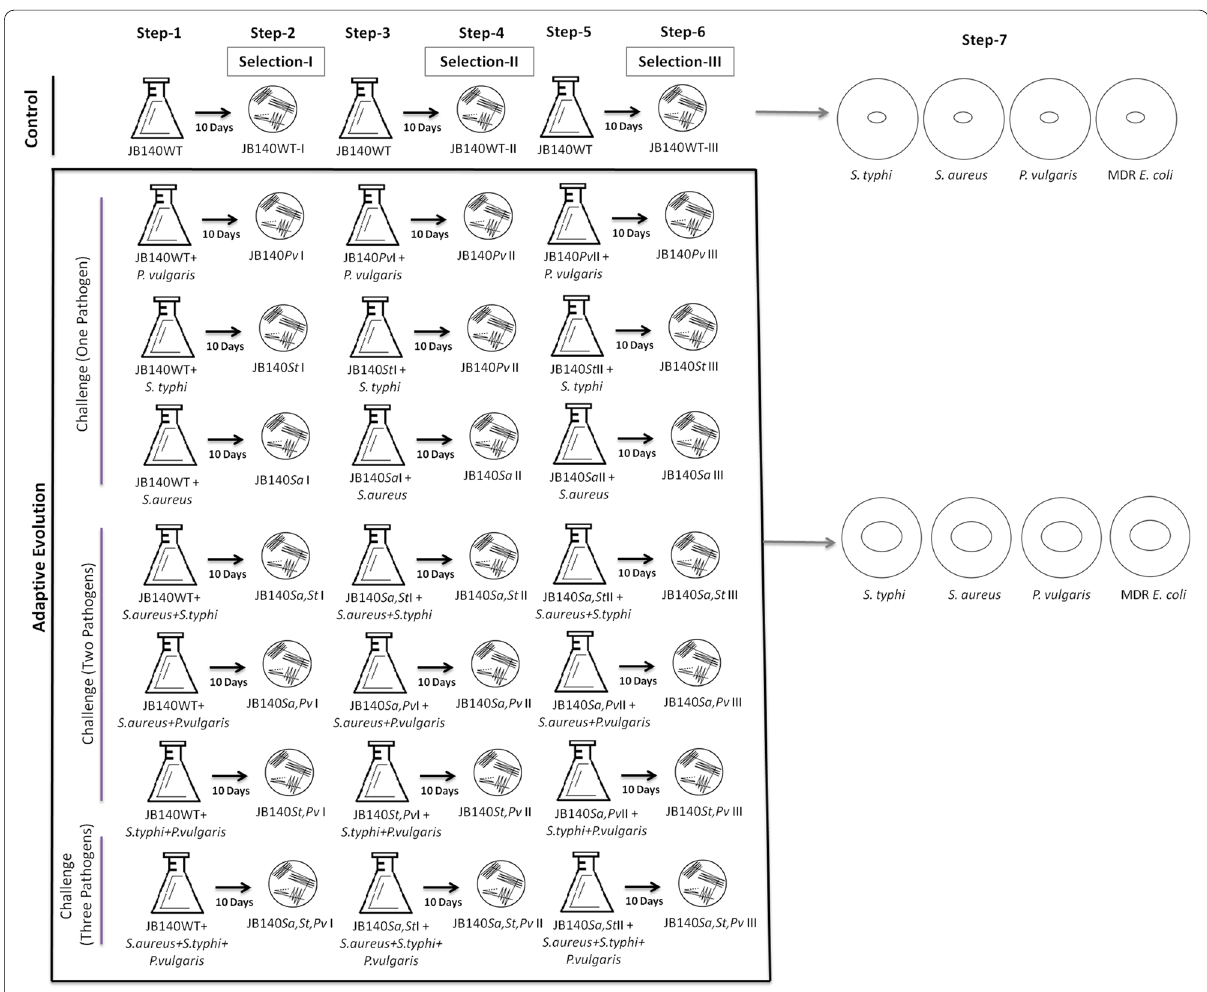
Fig. 1 Adaptive evolution protocol (seven-steps) wherein a weak antibiotic-producing Streptomyces strain JB140 was challenged against bacterial